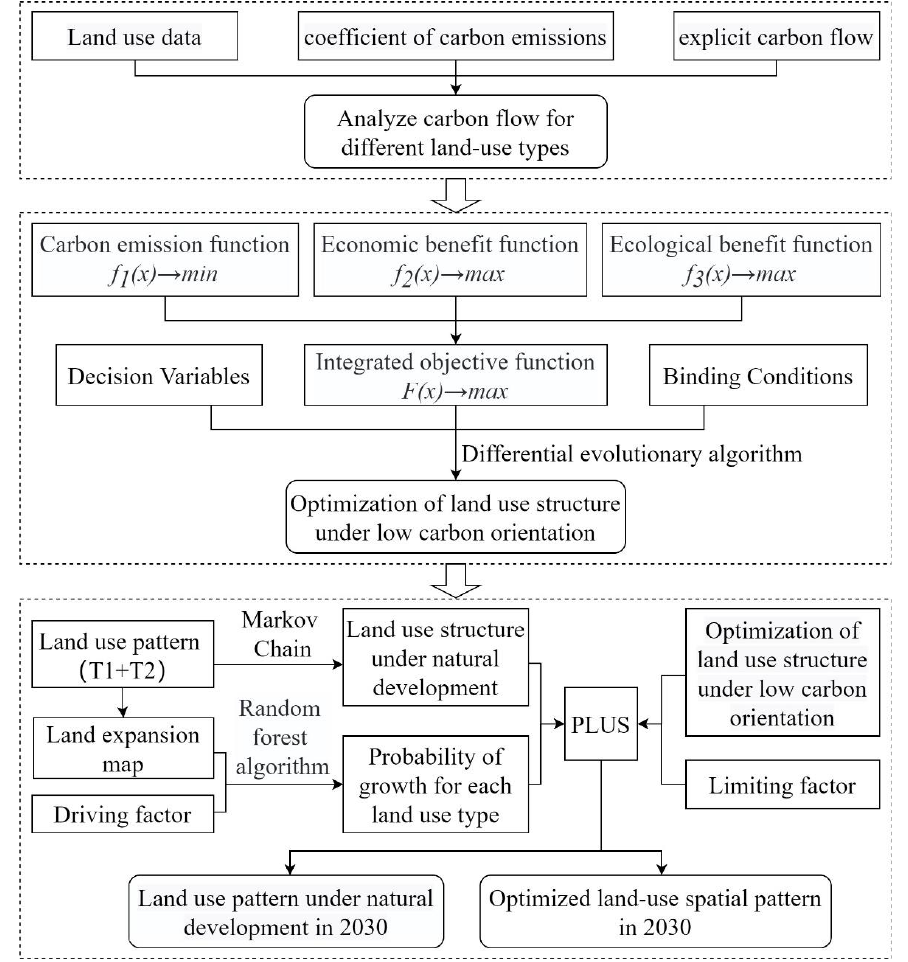
Figure 2. The roadmap of this study.